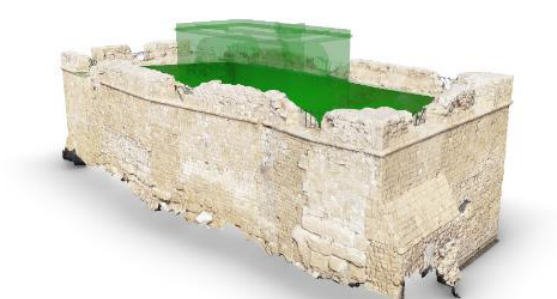
Figure 7. Paphos Castle seaside wall textured mesh in Rhinoceros software linked with the 3D Revit elements with green colour.